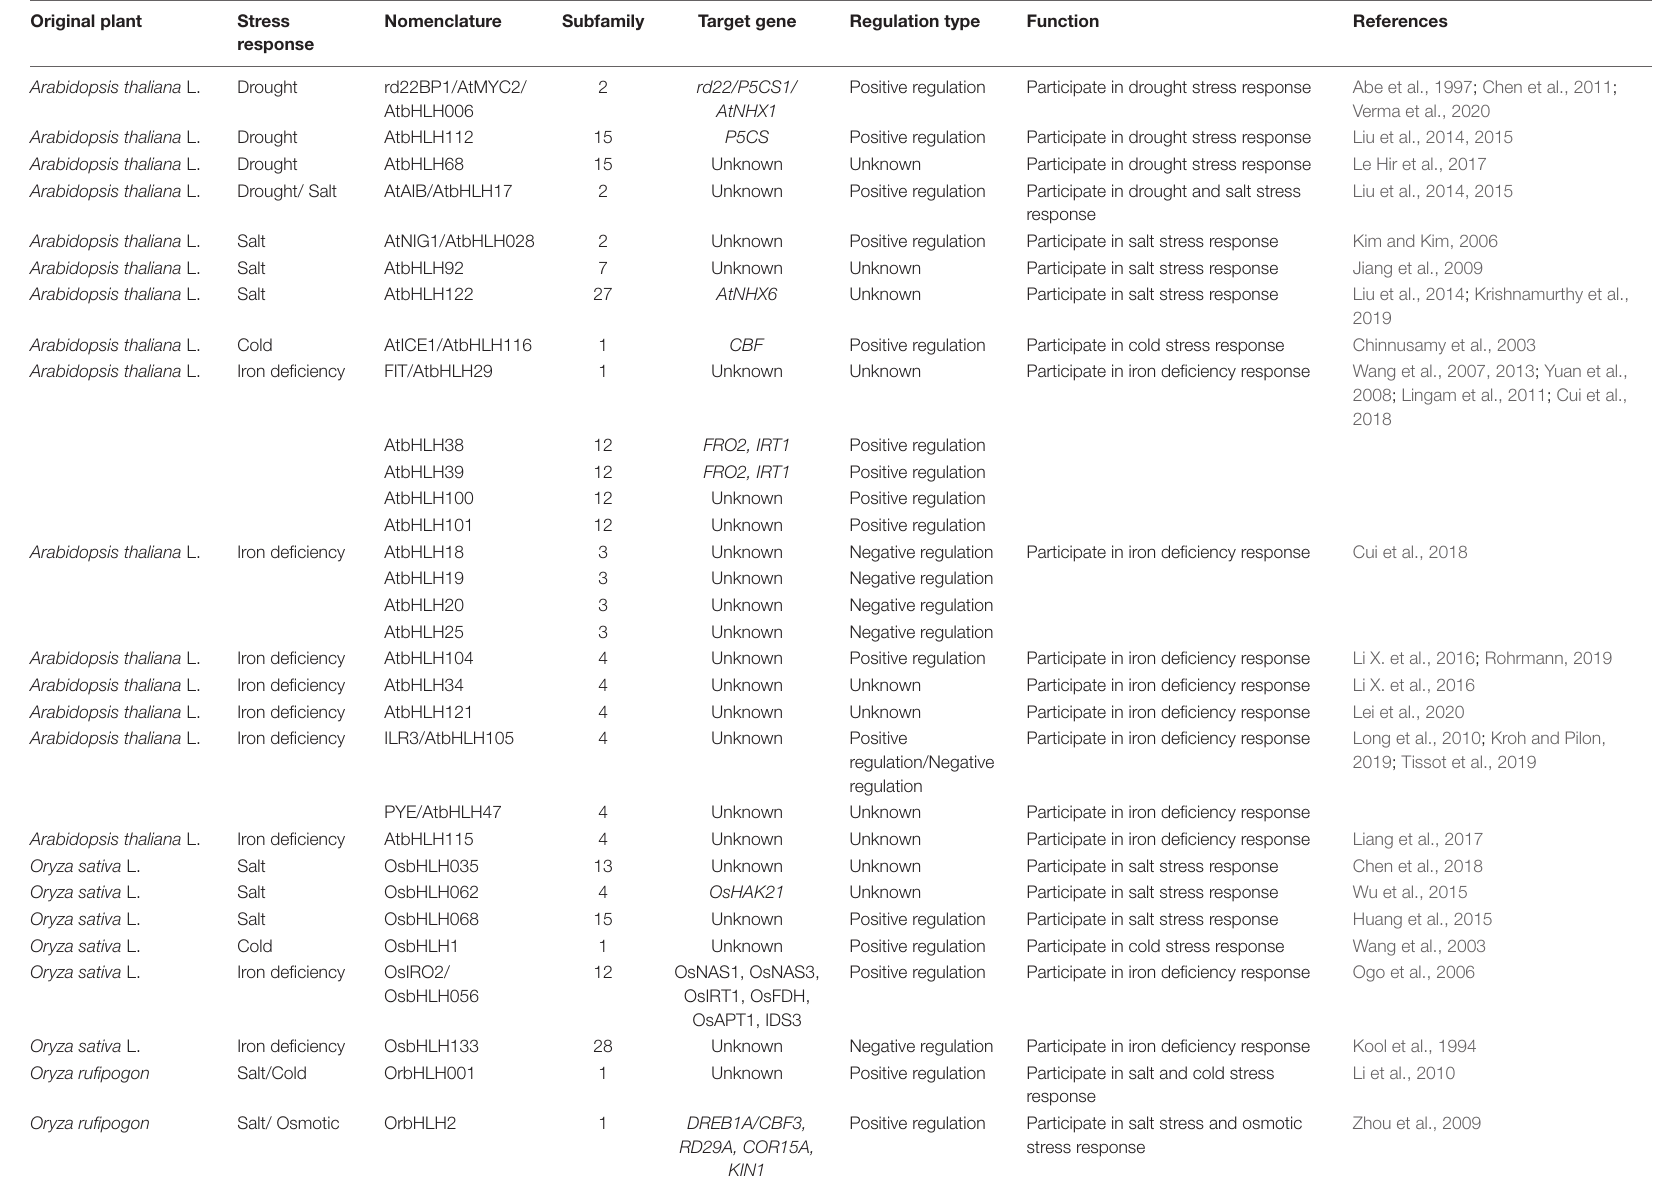
TABLE 2 | bHLH transcription factors involved in plant abiotic stress response. Original